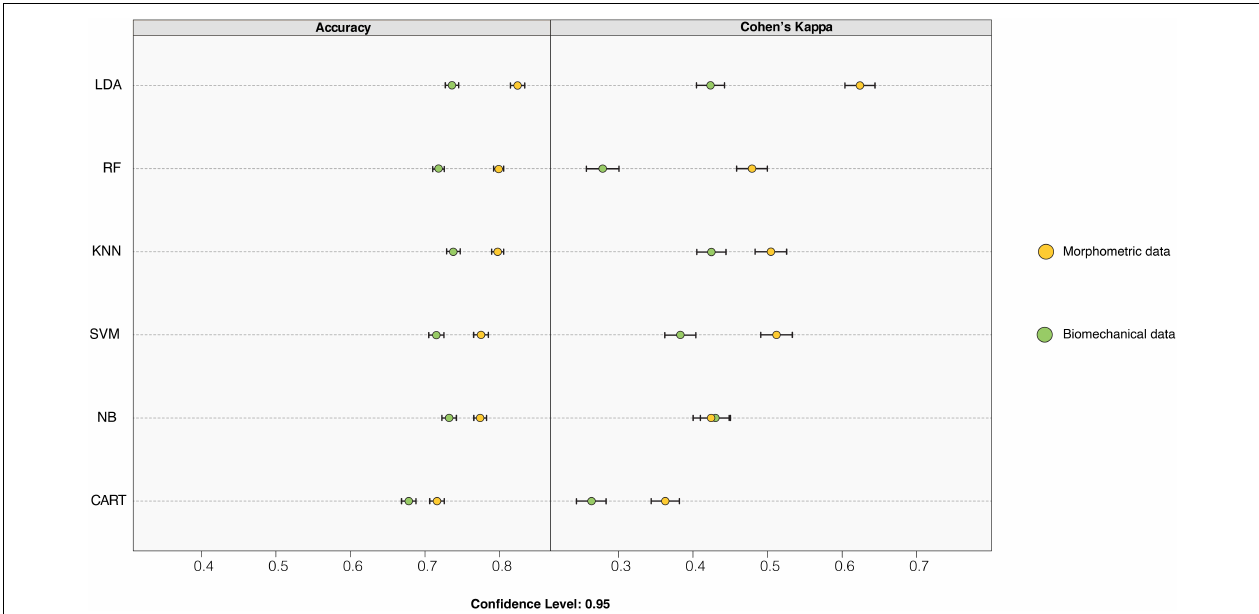
FIGURE 6 | Dot-plot comparing the accuracy and Cohen’s Kappa values of the different classification models applied to morphometric and biomechanical data. The dots represent the average accuracy and Cohen’s Kappa values after performing the “leave-group-out” cross-validation (200 repeats), while the whiskers display their respective 0.95 confidence level. Model acronyms: linear discriminant analysis (LDA); classification and regression tree (CART); k-nearest neighbors (KNN); naïve Bayes (NB); support vector machine (SVM) and random forest